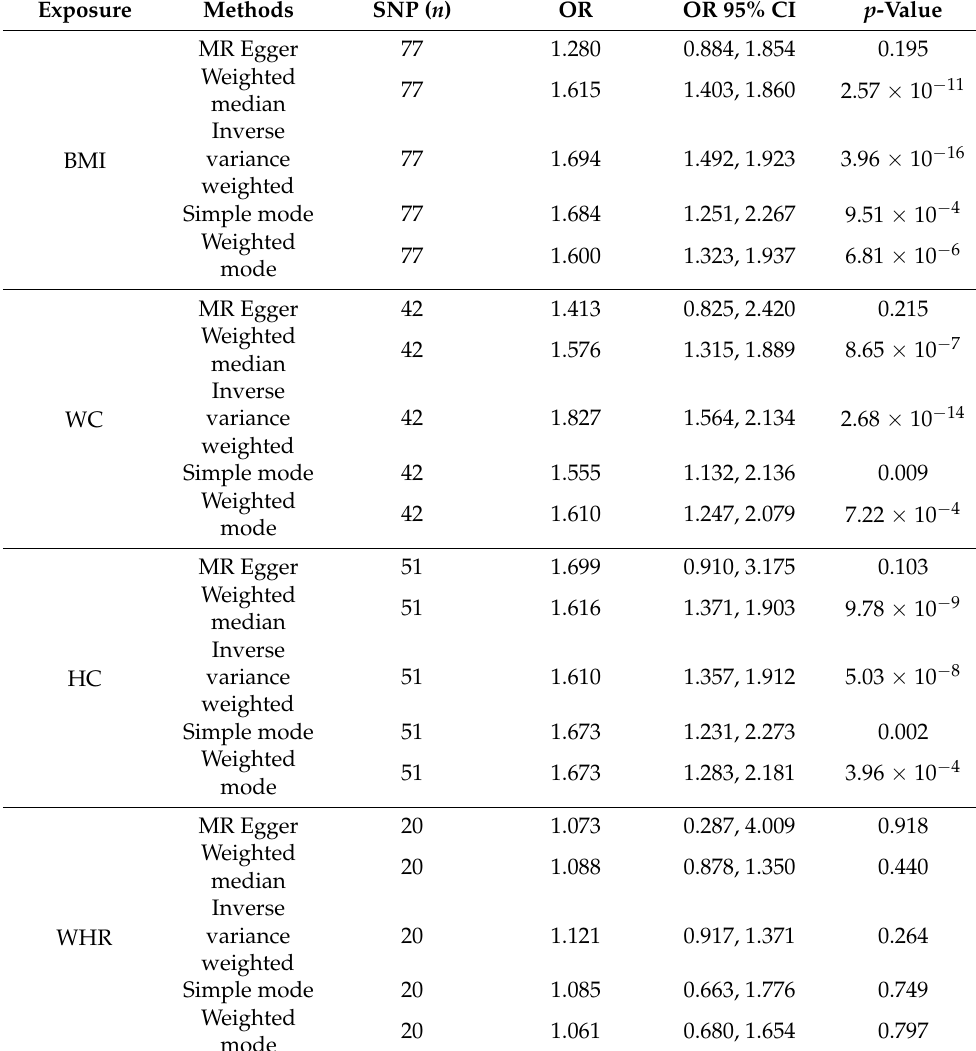
Table 1. The Mendelian randomization analysis results with regard to causal effect of BMI, WC, HC, and WHR on Knee osteoarthritis. Exposure Methods SNP ( n